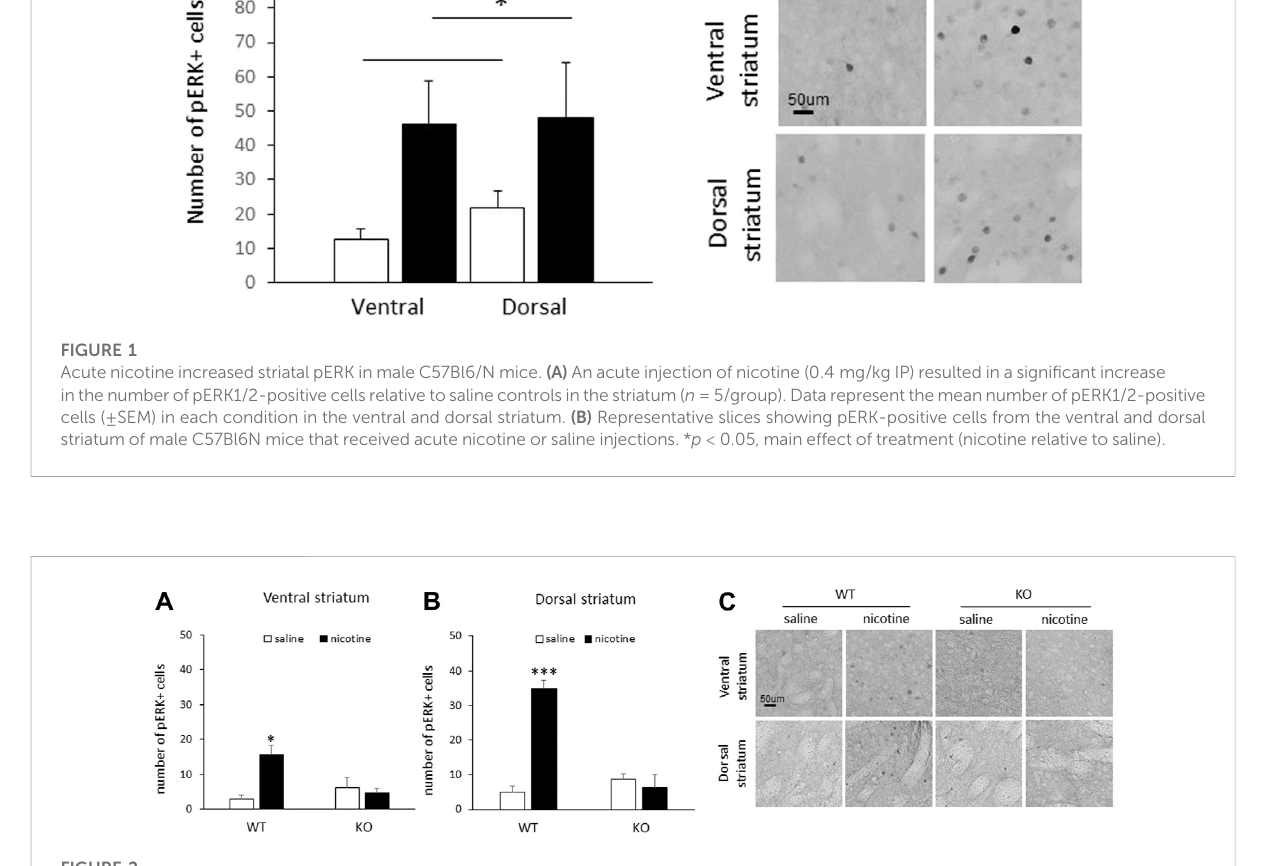
FIGURE 2 AcutenicotinefailedtoincreasestriatalpERKinmaleRasGRF2KOmice. (A) Anacuteinjectionofnicotine(0.4 mg/kgIP)resultedinasigni fi cant increase in the number of pERK1/2-positive cells relative to saline controls in the ventral striatum of male RasGRF2 WT, but not KO mice ( n = 3 – 4/ group). Data represent the mean number of pERK1/2-positive cells (±SEM) in each condition. (B) An acute injection of nicotine (0.4 mg/kg IP) resulted in a signi fi cant increase in the number of pERK1/2-positive cells relative to saline controls in the dorsal striatum of male RasGRF2 WT, but not KO mice ( n = 3 – 4/group). Data represent the mean number of pERK1/2-positive cells (±SEM) in each condition. (C) Representative slices showing pERK-positive cells from the ventral and dorsal striatum of male RasGRF2 WT and KO mice that received acute nicotine or saline injections. * p < 0.025; *** p <